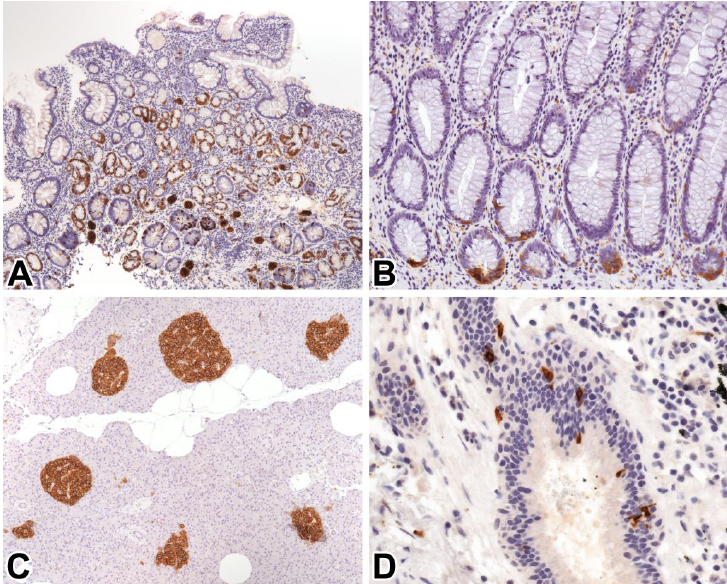
Figure 1. Syntaxin 1 (STX1) immunoreactivity in non-neoplastic tissues. ( A ) Nodular neuroendocrine (NE) cell hyperplasia in autoimmune metaplastic atrophic gastritis, 10x; ( B ) NE cells in normal colonic mucosa, 20x; ( C ) Langerhans islets in normal pancreatic tissue, 10x; ( D ) NE cells in normal bronchial mucosa,